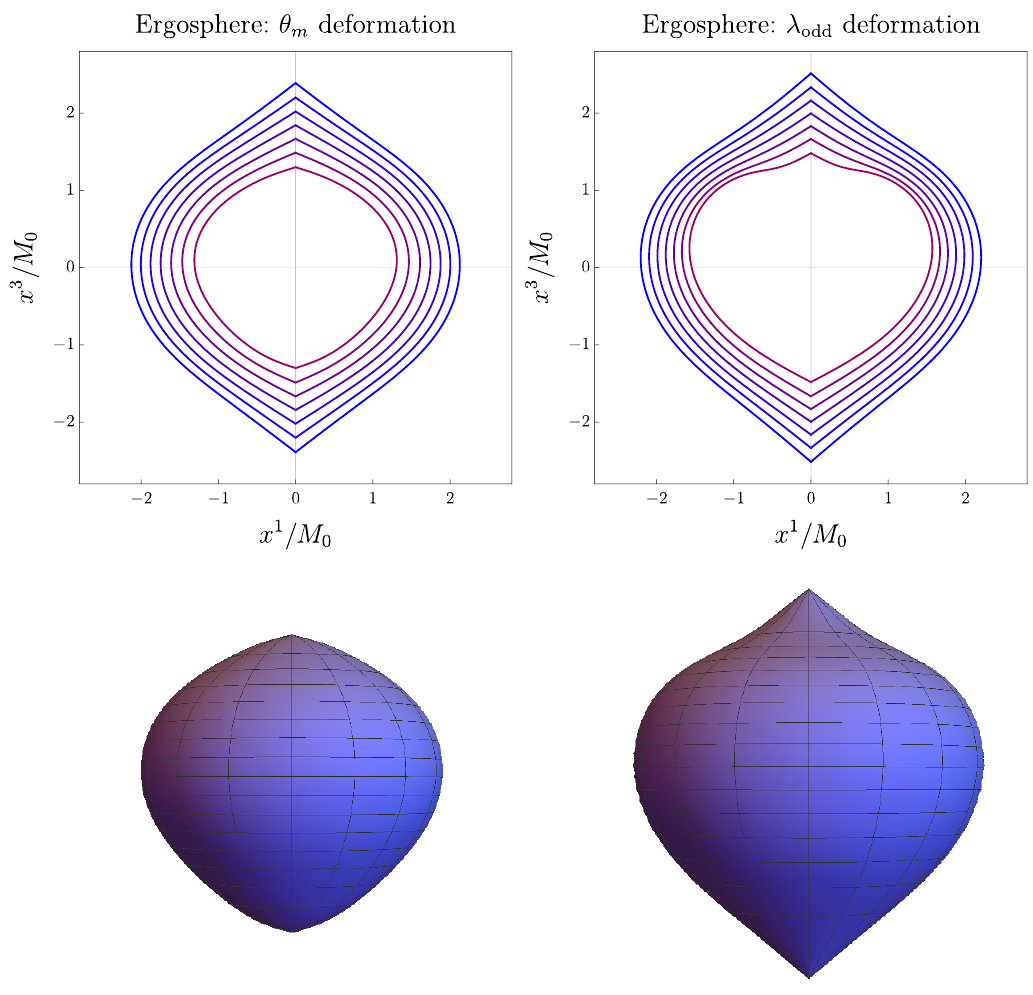
Figure 7 . Isometric embedding of the ergosphere in E 3 for parity-breaking theories. In the top row we plot the ergosphere for di(cid:11)erent masses ( M 0 (cid:21) M (cid:21) 0 : 7 M 0 for some reference mass M 0 ) while keeping (cid:31) = 0 : 65 and the couplings constant. In each case, only the indicated couplings are non-vanishing. Left: (cid:11) 1 = (cid:11) 2 , (cid:18) m = (cid:25)= 2, M 0 (cid:25) 2 : 23 ‘ the bottom row we show a 3D embedding of the ergosphere for ‘ 4 (left) and for ‘ 4 (cid:21) odd = 0 : 6 (right). In the latter case we observe clearly that the Z 2 symmetry is M 4 broken and the ergosphere acquires a characteristic \trompo" shape. The e(cid:11)ect is more subtle in the left picture, but the Z 2 symmetry is also